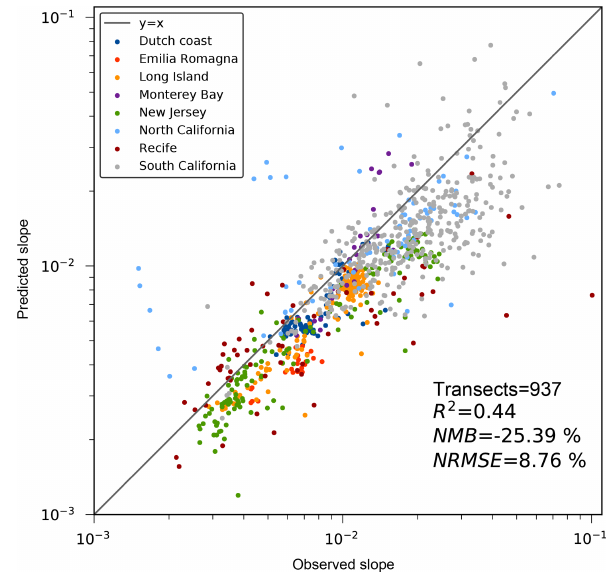
Figure 9. Linear regression between globally predicted nearshore slopes and nearshore slopes observed from local data for all study sites. Note that both axes are on a log